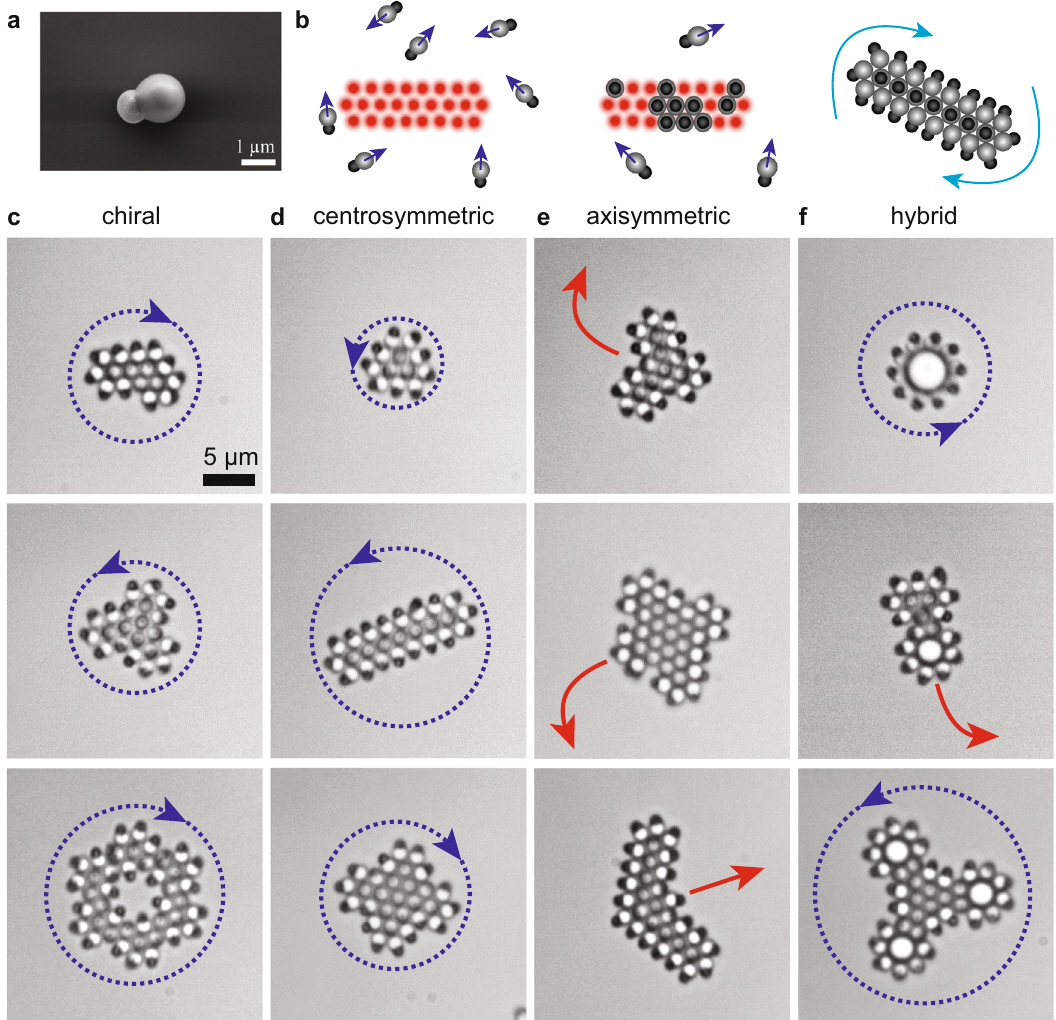
Fig. 1 Colloidal metamachines. a Scanning electron microscopy of a TPM-hematite heterodimer. b Optical assembling of a metamachine. An optical pattern of traps is superimposed to the blue illumination activating the heterodimers. They travel randomly on the substrate until they encounter an optical trap and reorient vertically. In the absence of propulsion, heterodimers are repelled by scattering of the trapping laser. Upon removal of the optical template, the structure is stable, particles reorient and the structure exhibits autonomous dynamics (see main text). c – f Bright- fi eld pictures of colloidal metamachines. c Chiral metamachines rotate in fi xed direction. d Centro-symmetric metamachines rotate by spontaneous symmetry breaking. e Axisymmetric metamachines with translational motion. f Hybrid metamachines composed of passive spheres and active heterodimers. Blue arrows indicate the direction of rotation, red arrows indicate the direction of propulsion. Identical scale for all